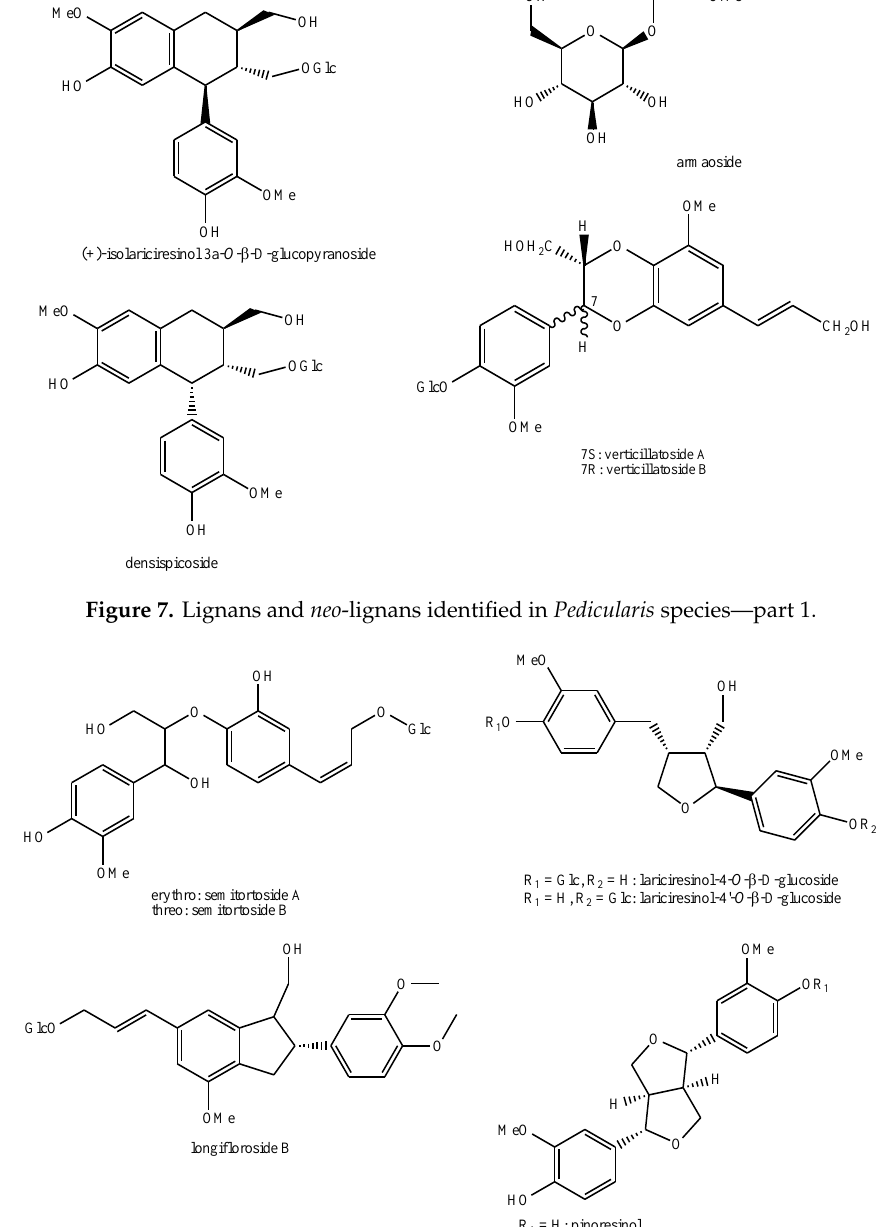
Figure 8. Lignans and neo -lignans identified in Pedicularis species—part 2.